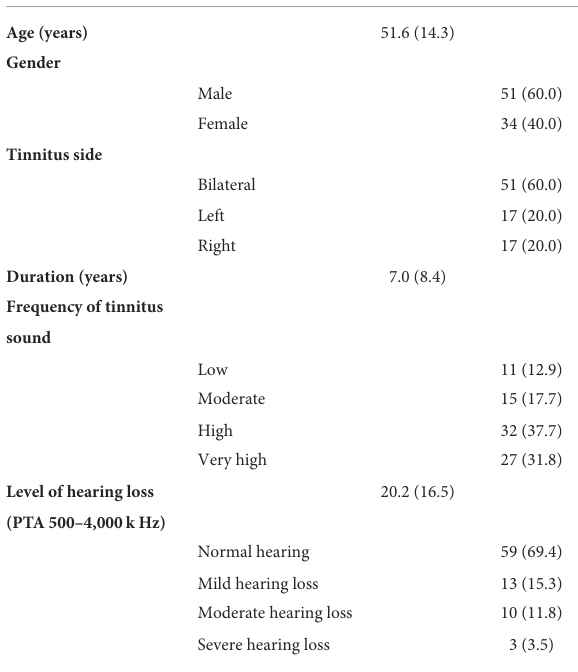
TABLE 1 Demographic and tinnitus characteristics of all